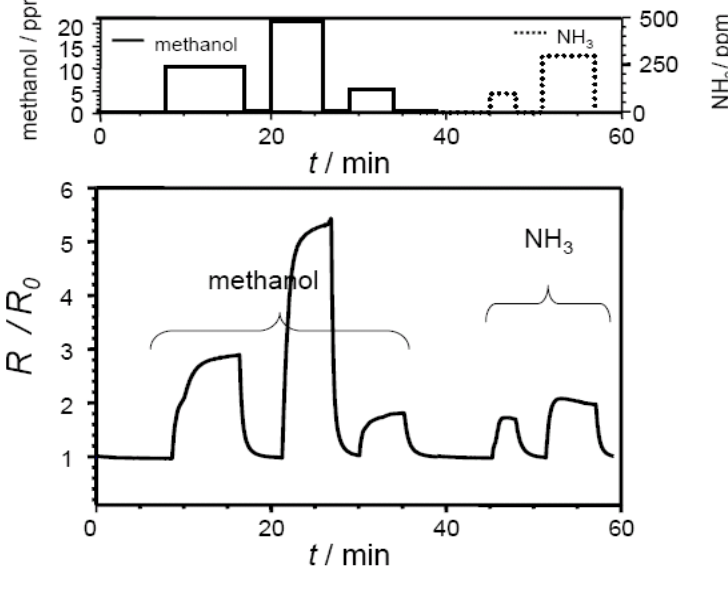
Figure 4. Sensor response of a SrTi analyte gases at 400 °C (concentration as indicated, balance: dry